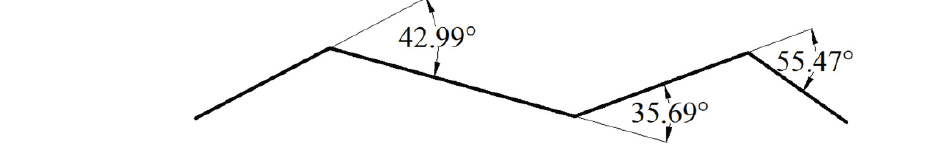
Figure 6. Deviation angles at segment points.